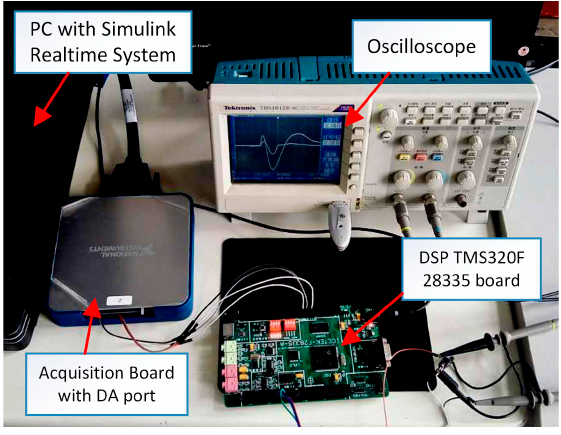
Figure 18. The experimental setup.